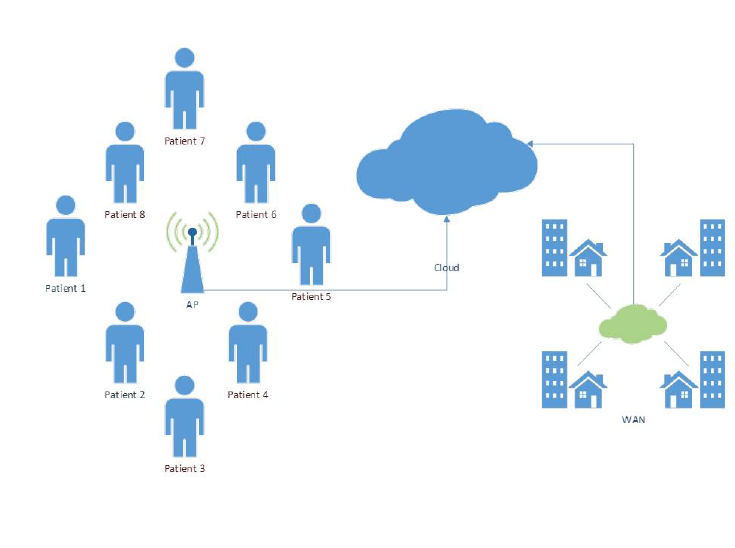
Figure 4. Network architecture. AP: Access point, WAN: Wide Area